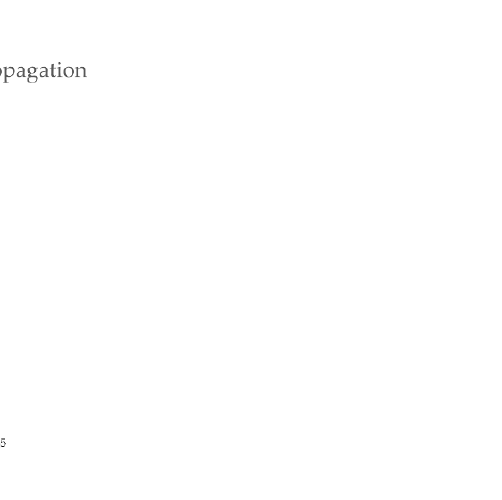
Figure 14. Number of cycles of the final measuring point as a function of the stress amplitude and additional Subdivision into the stages of crack initiation and short crack propagation, as well as long crack propagation for NSP-samples.